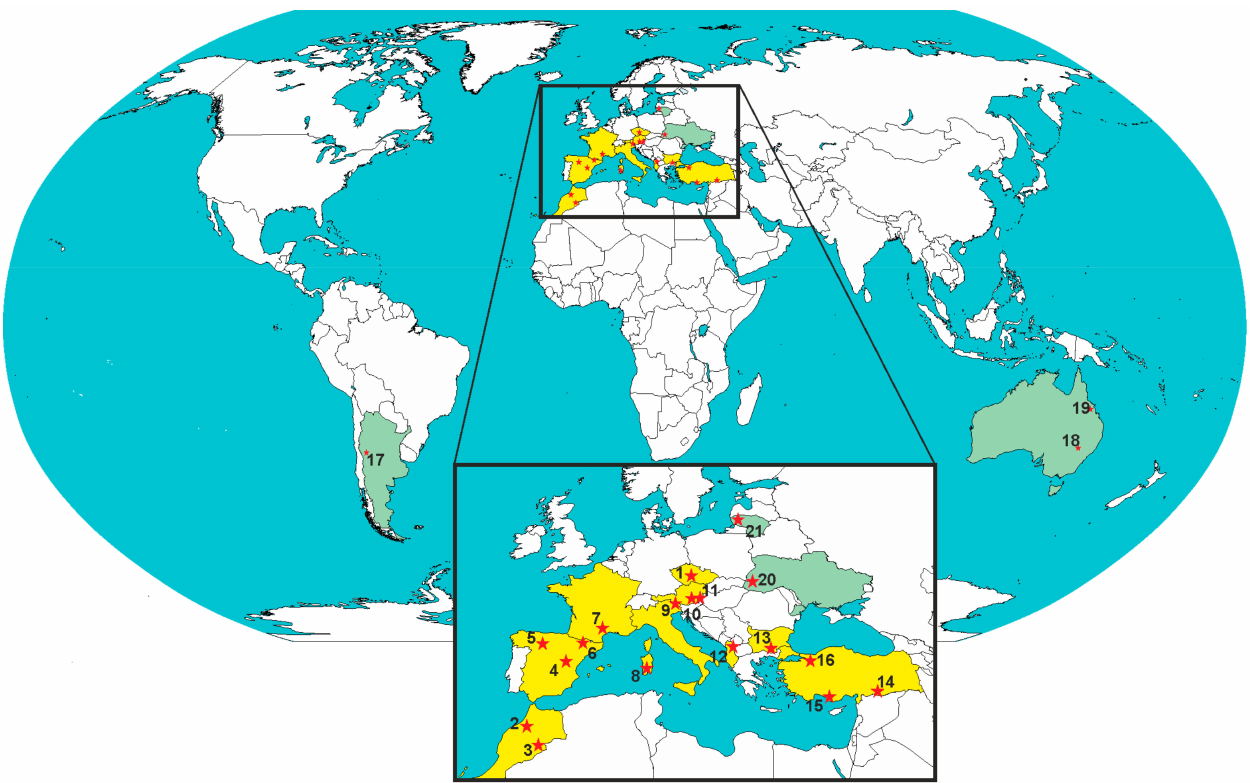
Figure 2. Main areas investigated in this paper. Yellow: northern Gondwana regions; green: